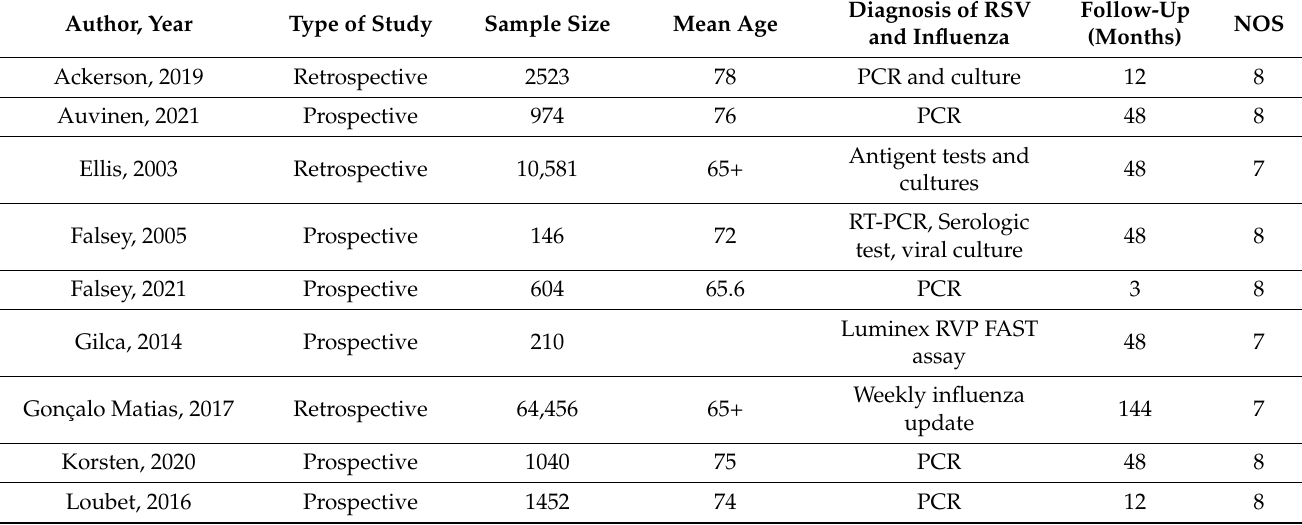
Table 1. Descriptive